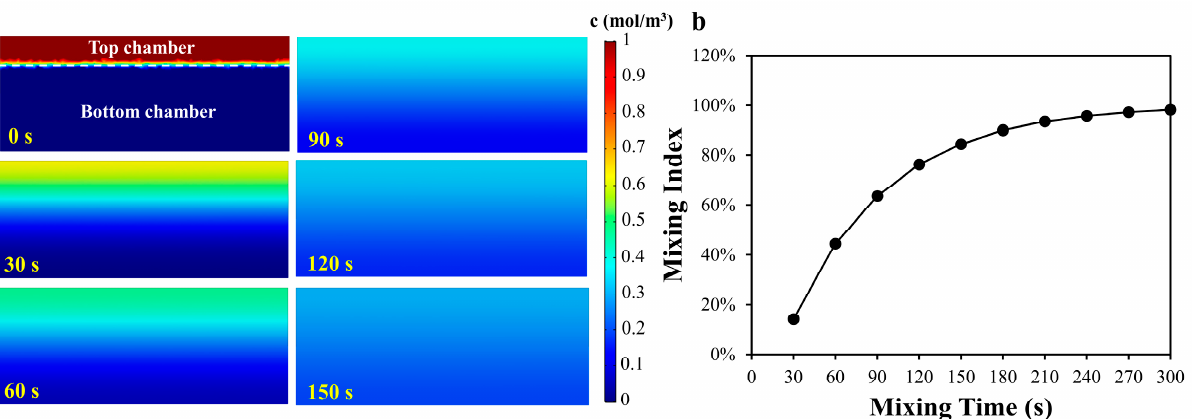
Figure 2. ( a ) The numerical concentration distribution of the cross section of the two microchambers; ( b ) The relationship between mixing index and mixing time.